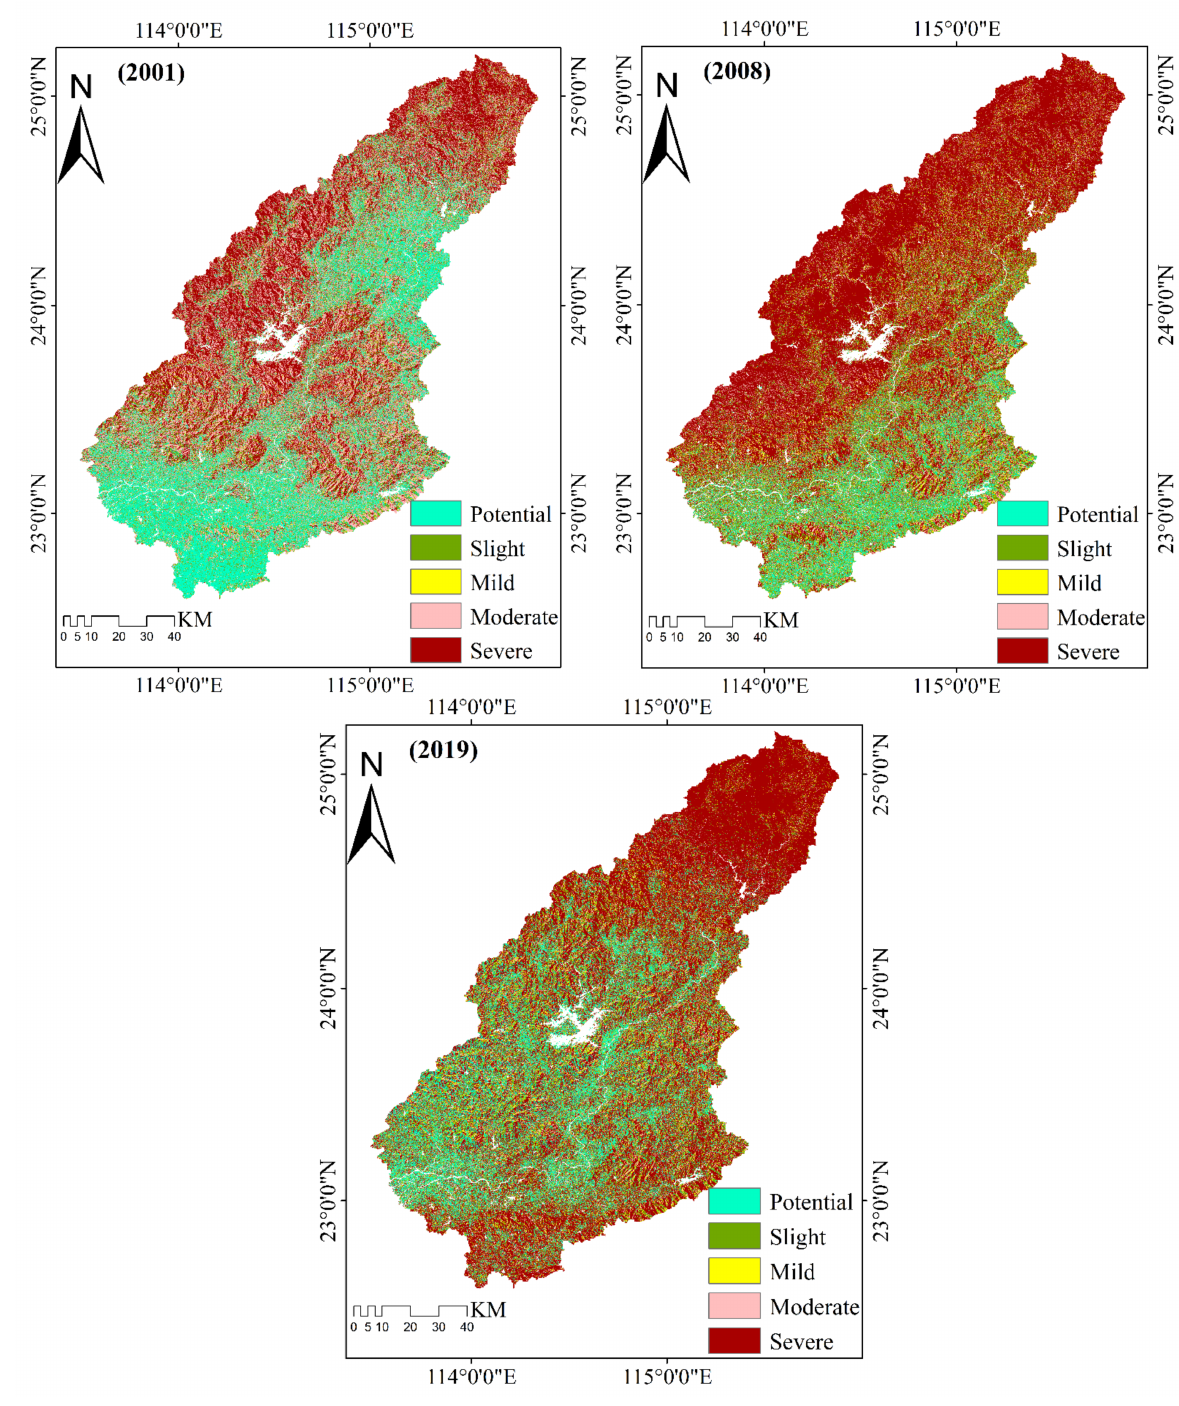
Figure 3. Distribution of EV levels in the DRB, 2001–2019. Table 4. Statistics on the percentage of area at each EV level in the DRB (2001, 2008, 2019).